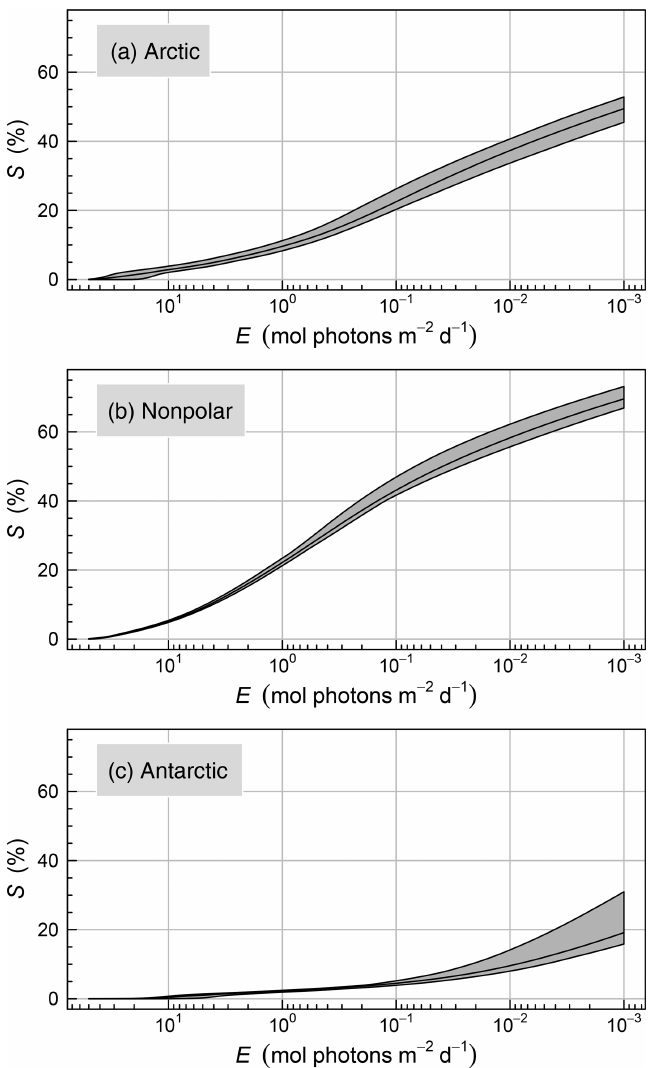
Figure A1. Cumulative surface area of the seafloor ( S ) receiving irradiance above a prescribed threshold ( E ). Data are expressed in percent of the total surface area of each region (19080010, 6100532, and 146171km 2 , respectively, for the nonpolar, Arctic, and Antarctic regions). The shaded areas show the monthly